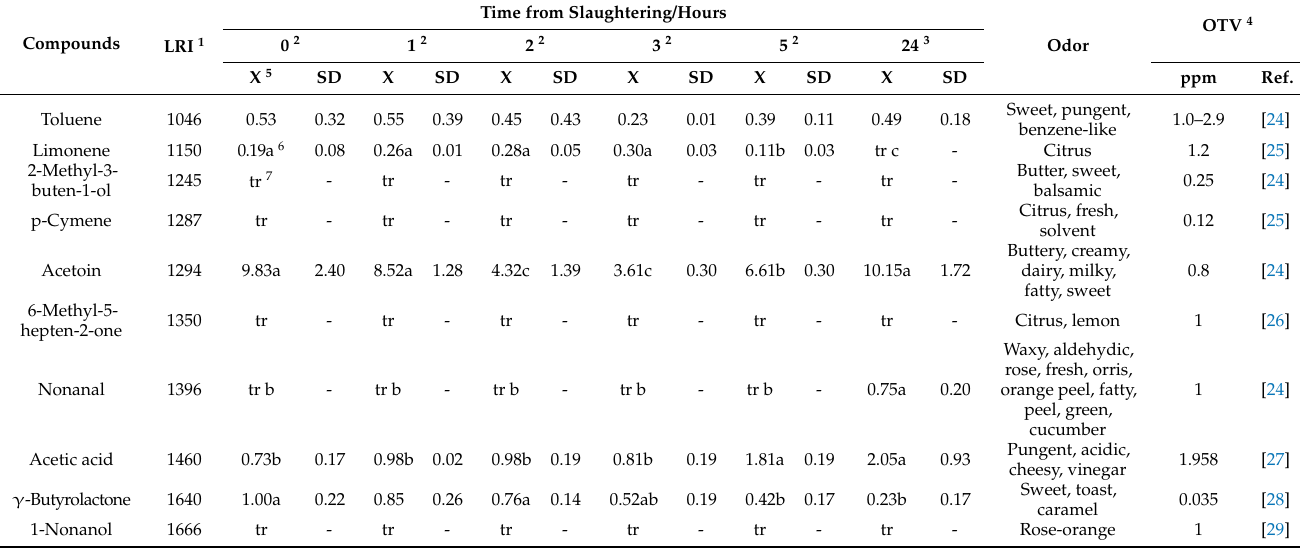
Table 4. Volatile compounds ( µ g/g of raw meat) released by meat at different times from